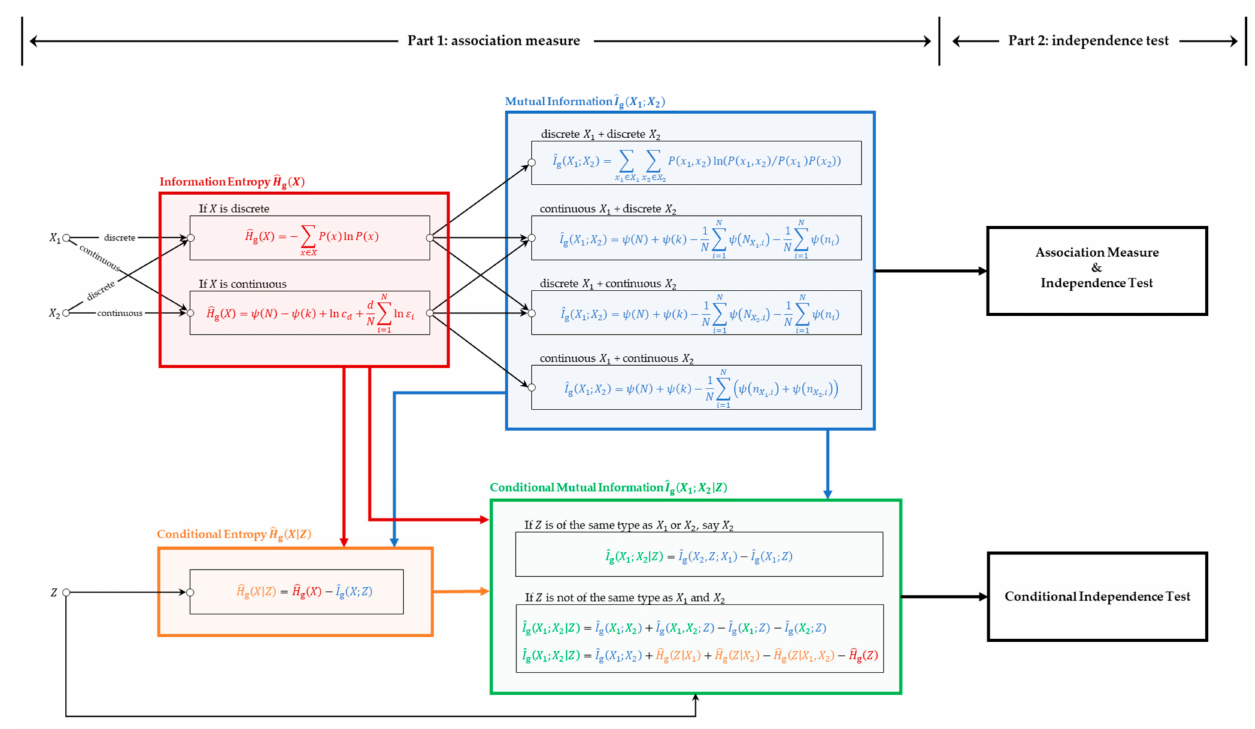
Figure 2. A general framework for